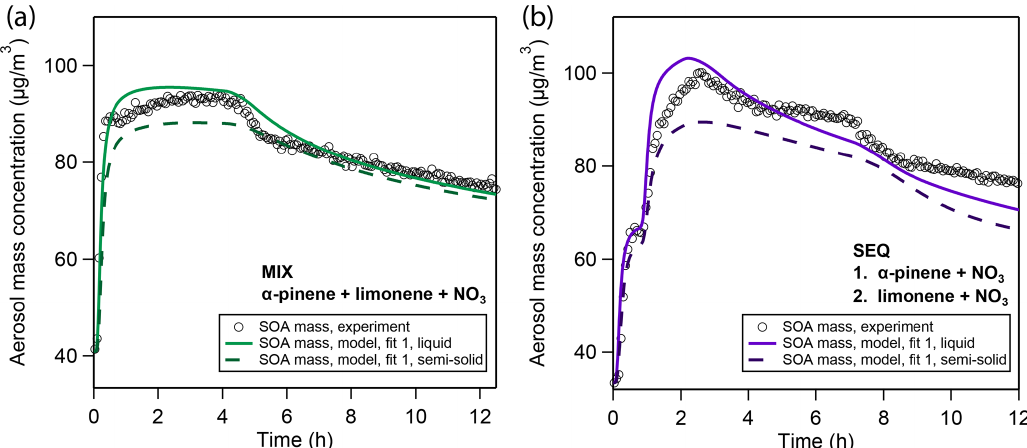
Figure 6. Sensitivity study on the influence of viscosity on model simulation results based on the best case fitting scenario in the (a) MIX and (b) SEQ experiments. Model simulations were performed for the default well-mixed case (solid lines) and at a diffusivity coefficient of 1 × 10 − 16 cm 2 /s, which corresponds to a bulk viscosity of 1 × 10 7 Pas according to the Stokes–Einstein relation and falls within the semi-solid phase state